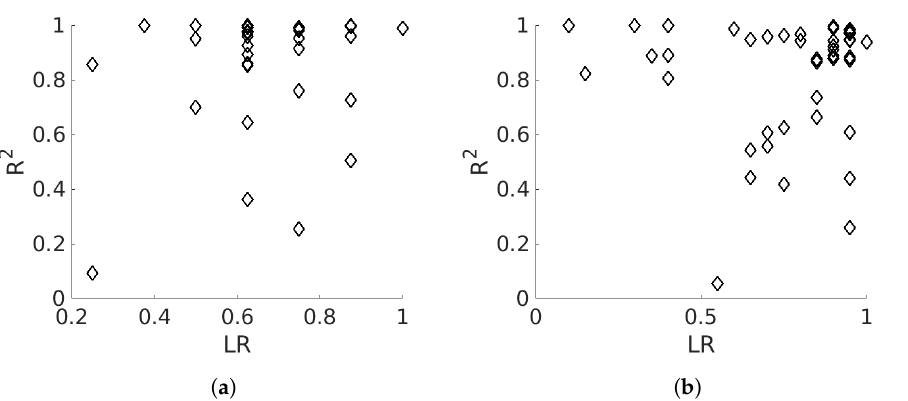
Figure 12. Scatter plots of trace length (LR) effect on the R 2 value for ( a ) cooling and ( b ) heating processes. A visualization of summary statistics for the R score and the ranking grouped by the simulation frame number are presented in Figure 13 as a box plot. The bottom and the top of each box are the 25th and 75th percentiles of the sample, respectively. The red line inside each box is the sample median. The whiskers extend to the adjacent values, which correspond to approximately ± 2.7 σ . Observations beyond the whisker length are outliers marked as a red + sign only in Figure 13b. Outliers for R score were omitted in Figure 13a so as not to clutter the